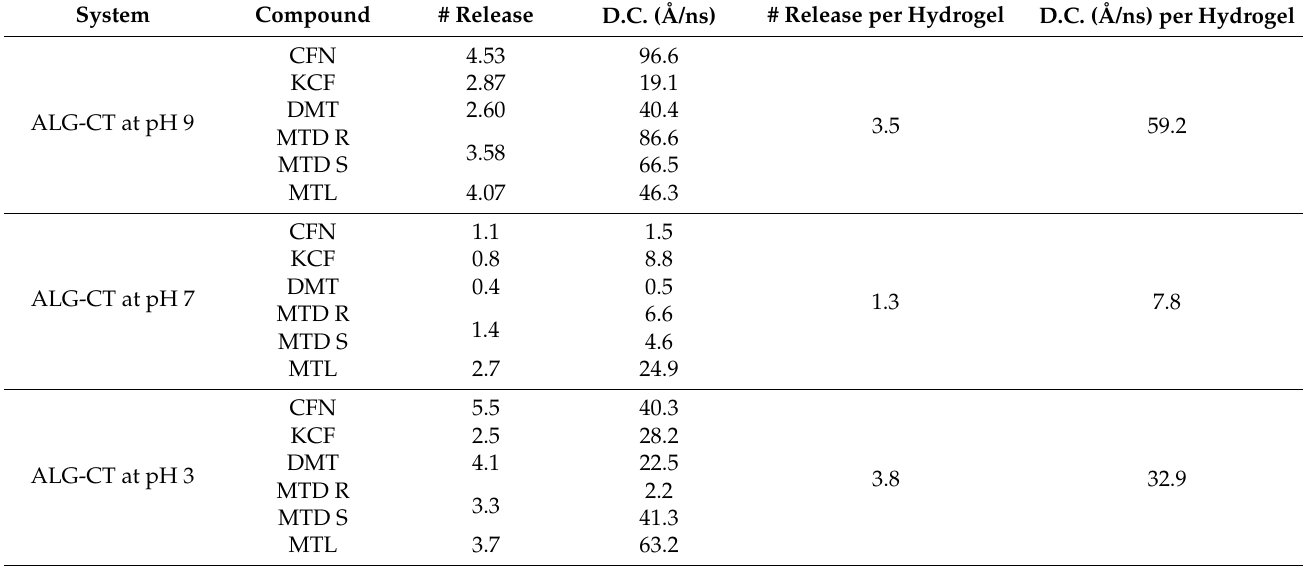
Table 1. Release and diffusion coefficients (D.C.) of selected compounds in ALG-CT systems at different pH values. The release of pesticides was calculated during the simulation by counting, in each step, the pesticide molecules located more than 5 Å away from the hydrogel. The release values (# Release and # Release per Hydrogel) correspond to the average of all the steps.